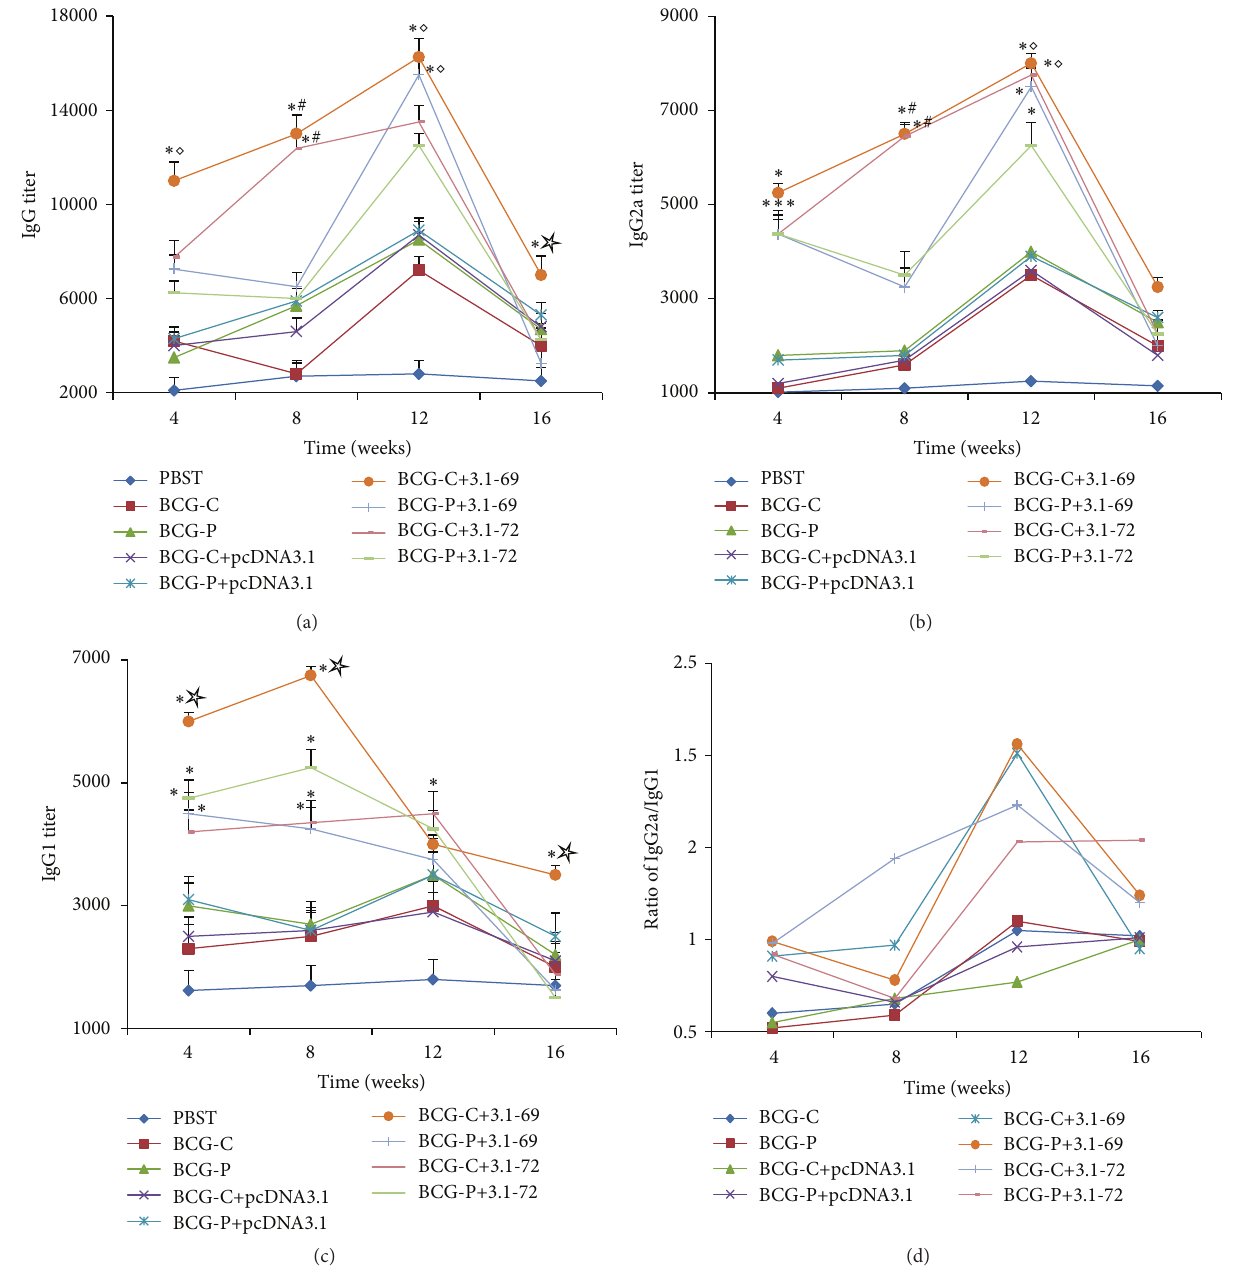
Figure 1: Analysis of the antibody responses via testing the IgG, IgG1, and IgG2a by ELISA. Animals were immunized and harvested at the indicated time points. The sera were obtained and tested for specific antibody levels. Results are expressed as mean ± standard errors. ∗ 𝑃 < 0.01 versusPBST, BCG-C,BCG-P,BCG-C+pcDNA3.1, orBCG-P+pcDNA3.1 groups. # 𝑃 < 0.01 versusBCG-P+3.1-69orBCG-P+3.1-72 group. ◊ 𝑃 < 0.05 versus BCG-P+3.1-72 group. f 𝑃 < 0.05 versus BCG-P+3.1-69, BCG-C+3.1-72 or BCG-P+3.1-72